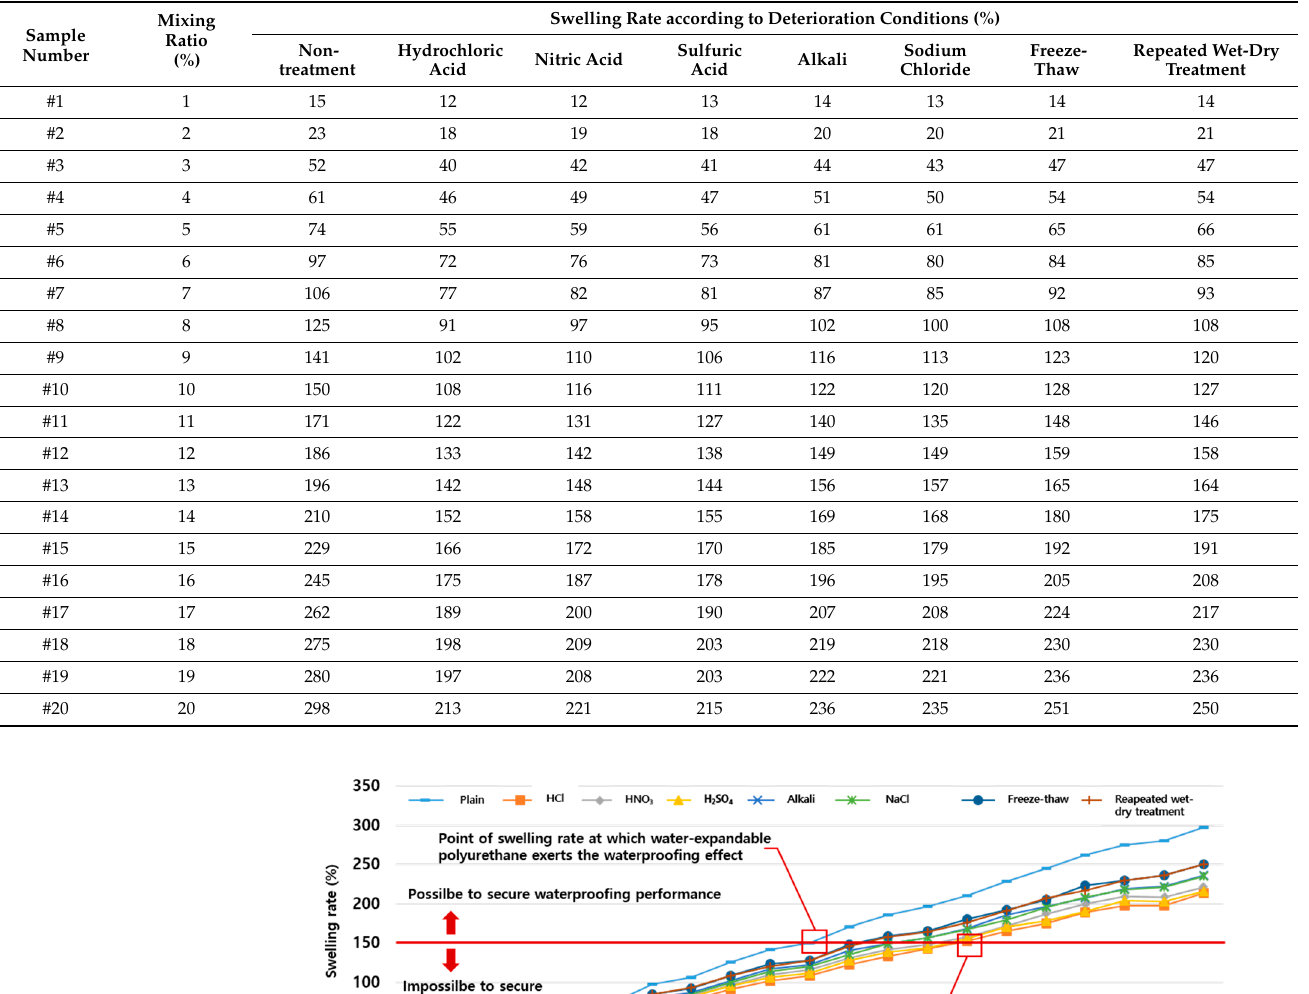
Table 7. The swelling rate test results under deterioration conditions according to the superabsorbent polymer content.